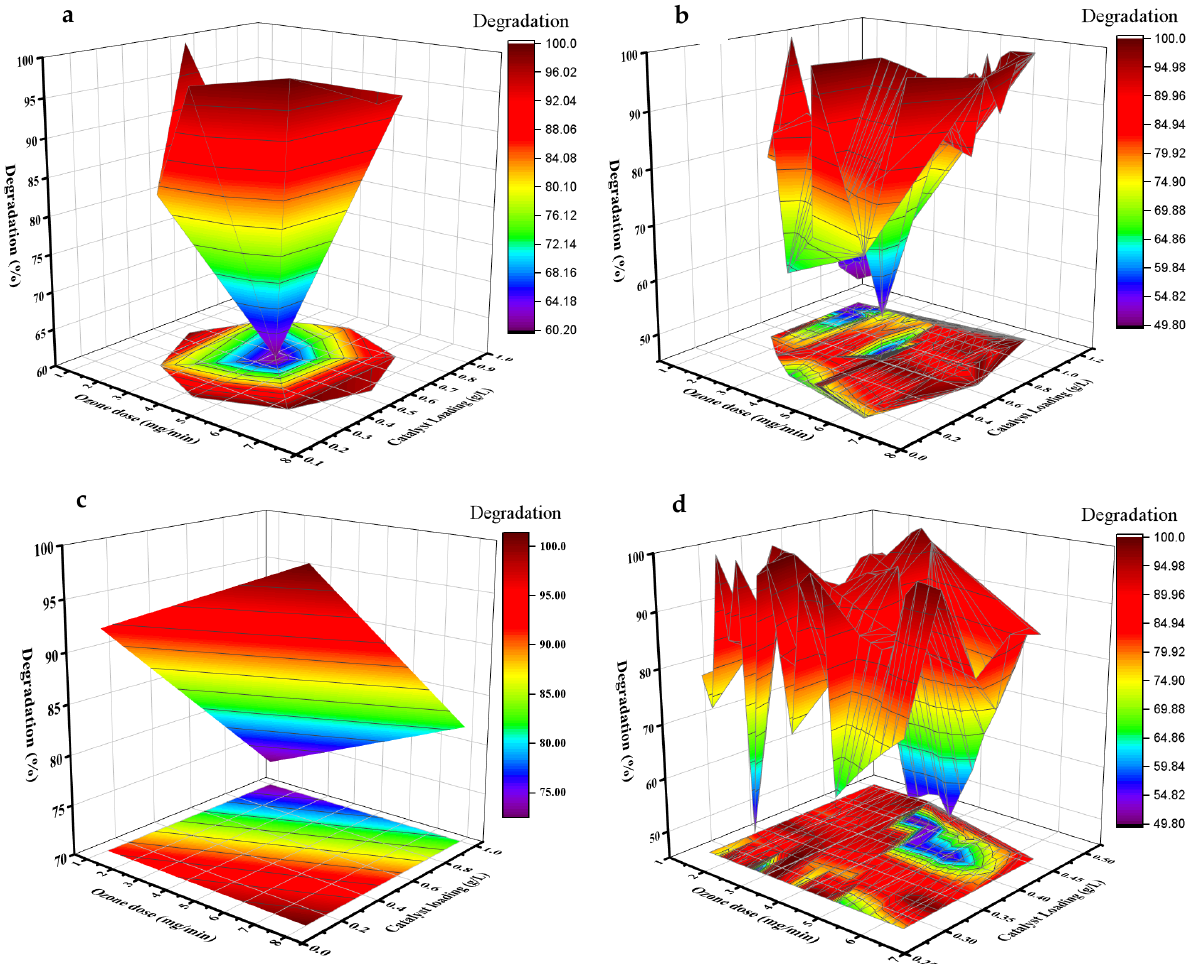
Figure 7. Ozone dose and suitable catalyst load according to a projection of experimental data ( a ), response surface ( b ), SSA model proposal ( c ), and PBRE model ( d ).